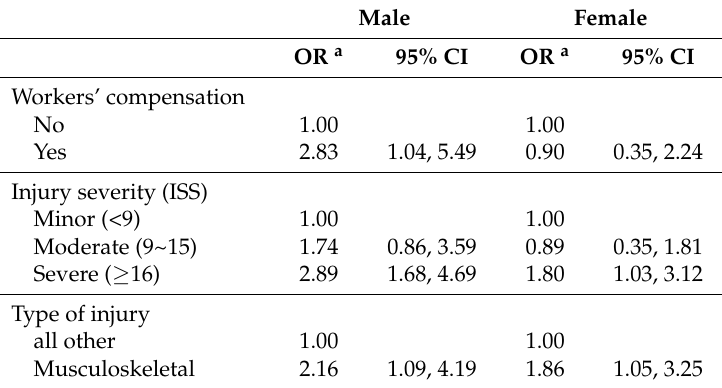
Table 3. Proportional odds of depression by injury characteristics among occupationally injured MEPS population, stratified by gender. Male Female OR a 95% CI OR a 95% CI Workers’ compensation No 1.00